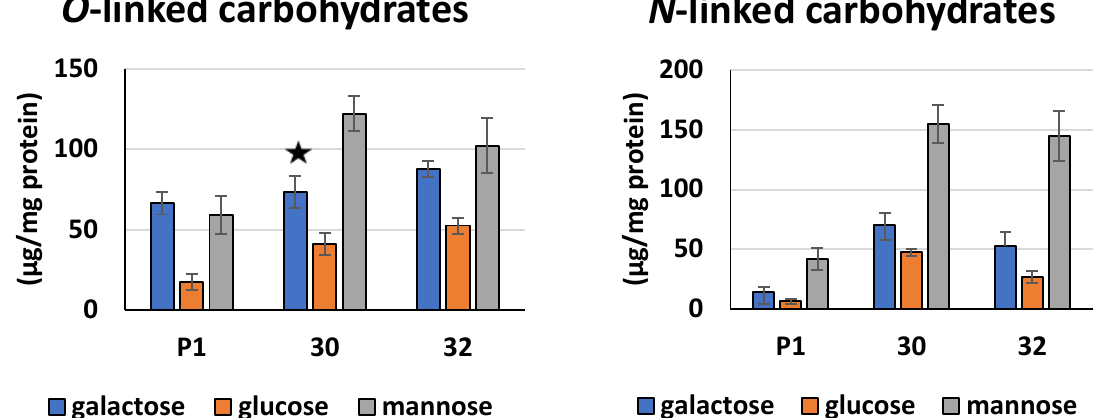
Figure 6. Content of O - and N -linked carbohydrates in proteins secreted by RER2 transformed T. atroviride after 96 h of cultivation. O - and N -linked carbohydrates were released selectively from proteins secreted by transformants (30—RER30/11; 32—RER32/11) and control strain P1 and determined by high-performance anion-exchange chromatography. Data are presented as mean ± standard deviation from three independent experiments. (cid:70) —differences statistically insignificant ( p < 0.05; t